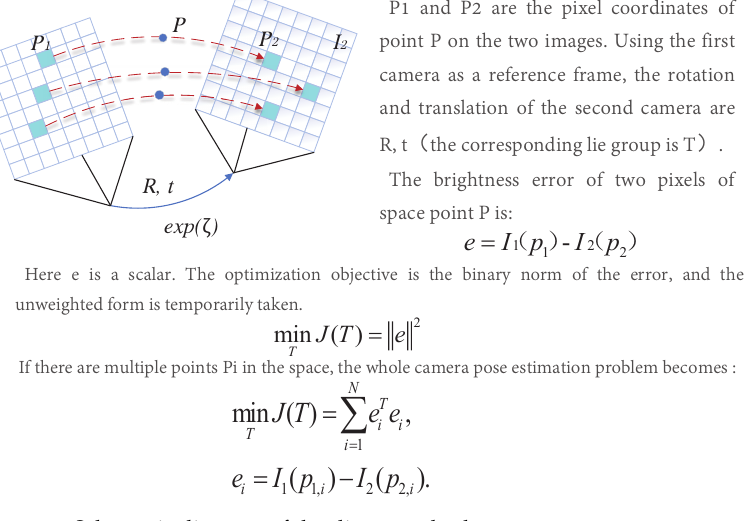
Figure 12. Schematic diagram of the direct